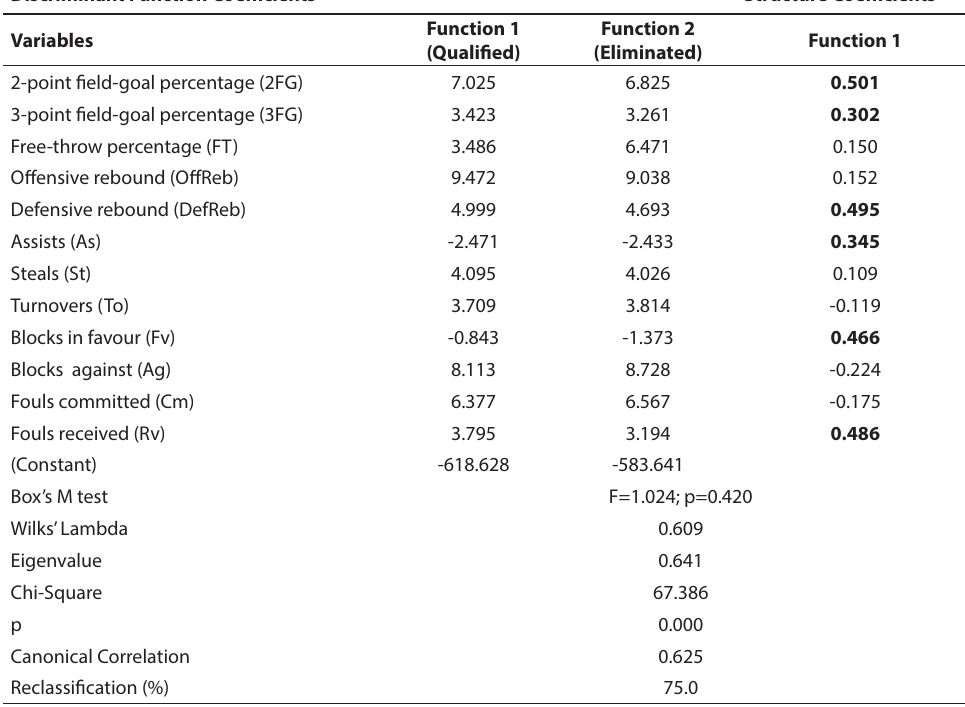
TABLE 1 Discriminant analysis results for the fi rst